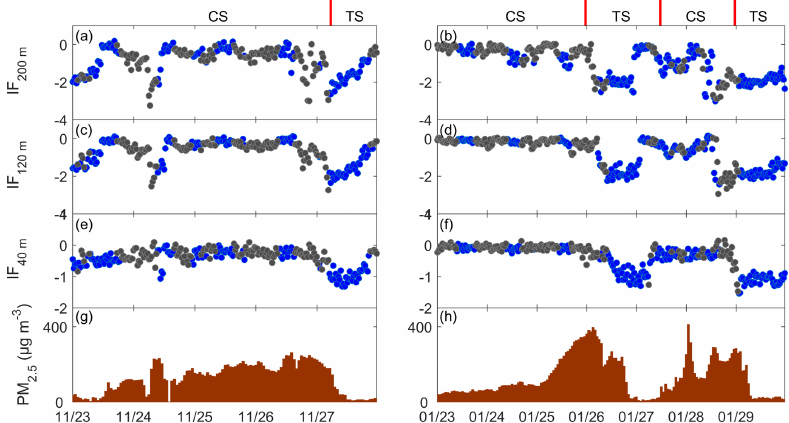
Figure 6. Distribution of (a) – (f) IF at three levels and (g, h) concentration of PM 2 . 5 at the surface. The left-hand panel represents Case-1 and the right-hand panel represents Case-2. Grey dots denote stagnant wind with a vertical wind speed of less than 0.3ms − 1 .